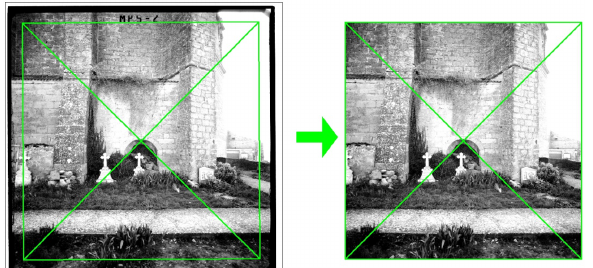
Figure 7. Interior orientation of the images. Original picture after scanning (left) and clipped image (right), green lines show the 5x5 cm area centred in the principal point of the photograph.